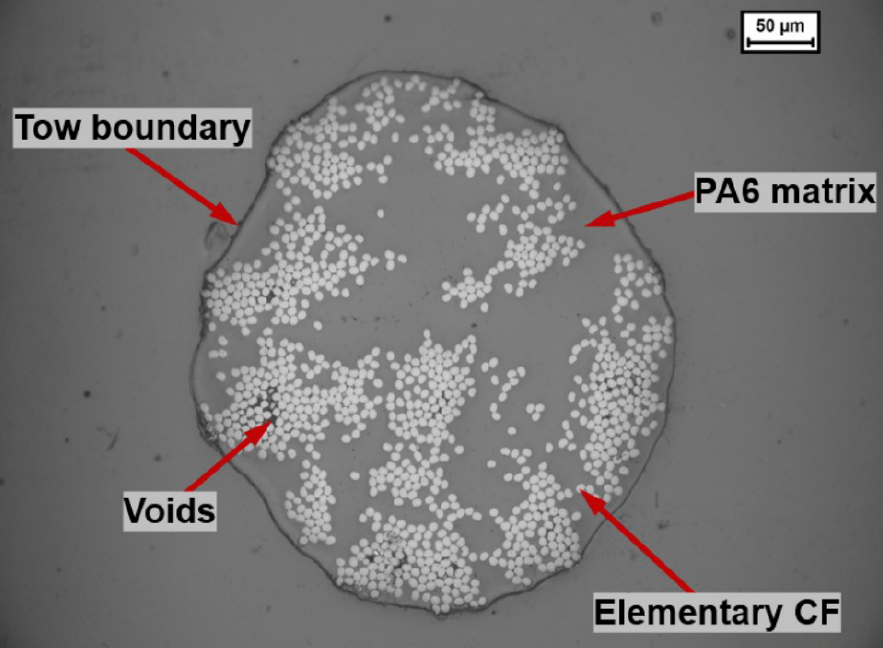
Figure 7. Typical cross-sectional view of a CF/PA6 filament by optical microscopy